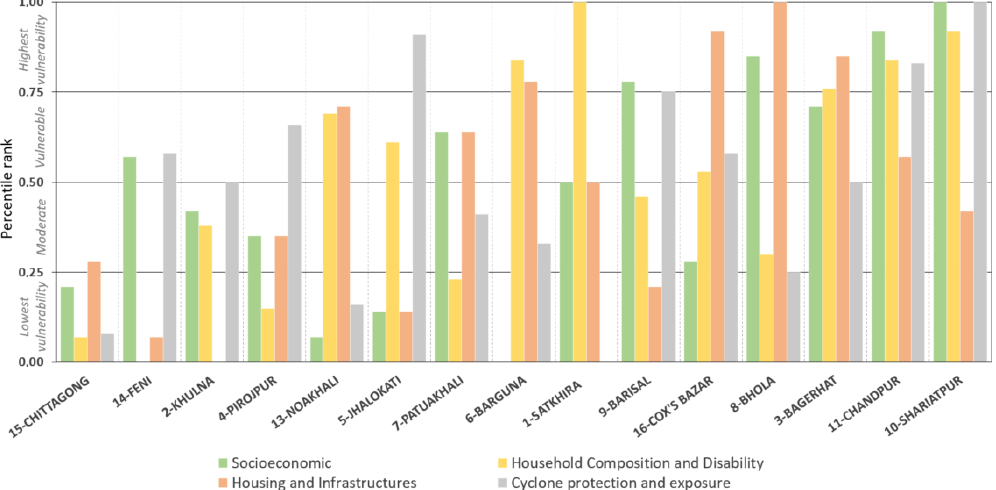
Figure 4. Contribution of each domain to the socio-spatial vulnerability